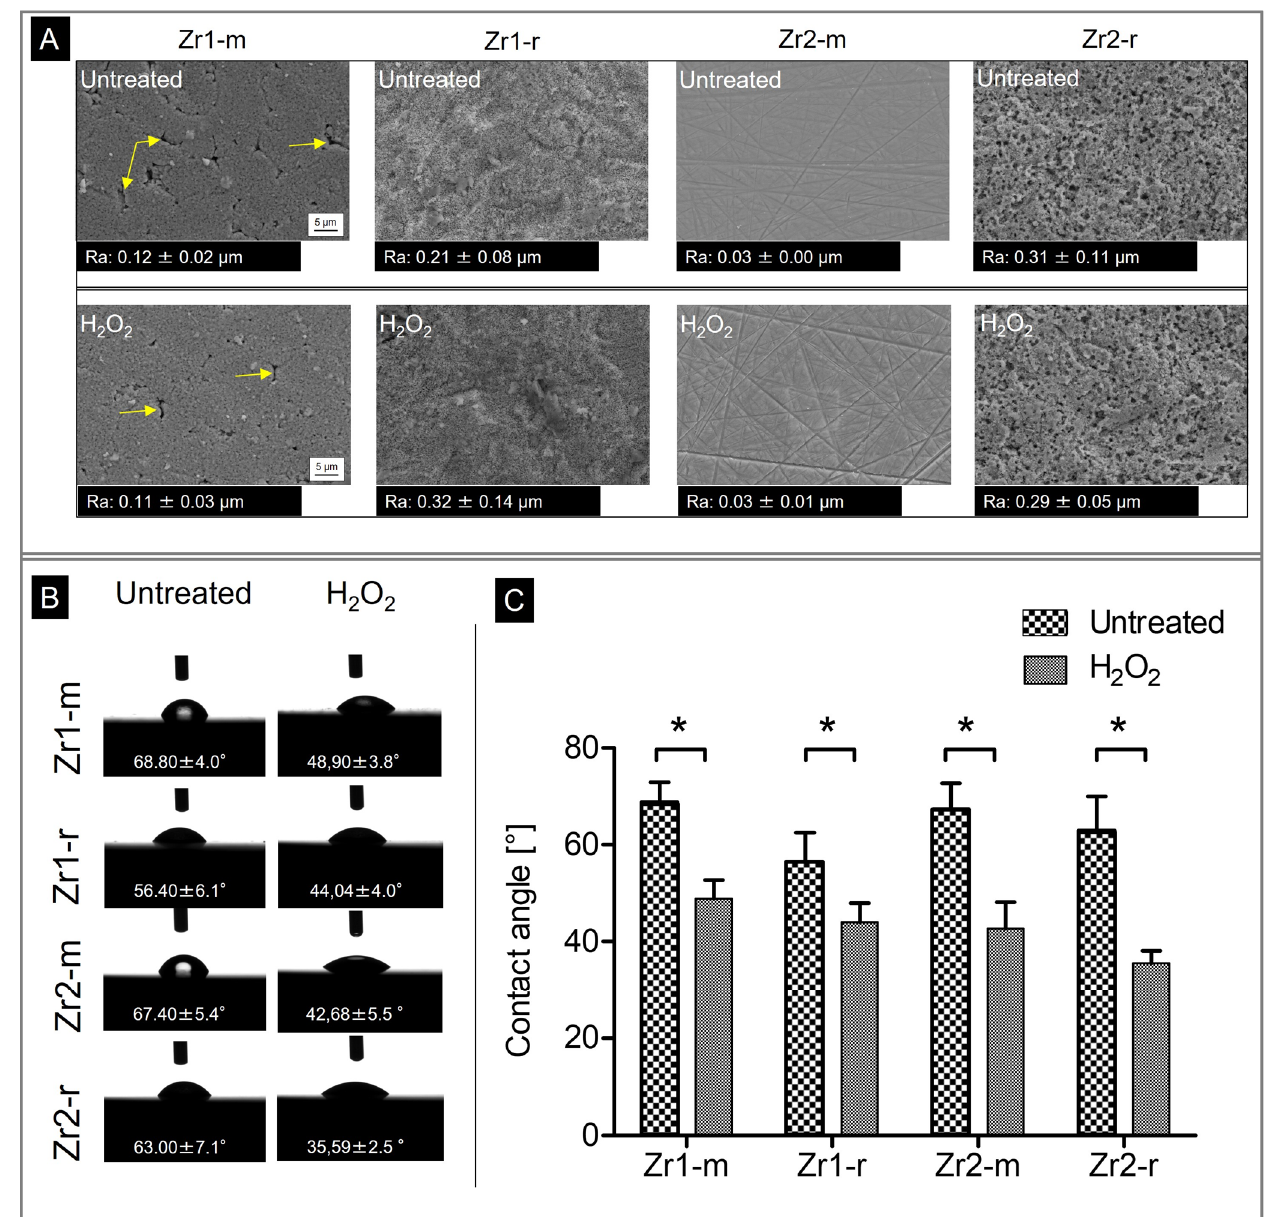
Figure 1. ( A – C ) Morphology of the zirconia-based surfaces before and after H 2 O 2 -treatment and changes in their hydrophilic properties after H 2 O 2 -treatment. ( A ) SEM images at 5000 × magnification of the four untreated and H 2 O 2 -treated surfaces Zr1-m/r and Zr2-m/r (mean average roughness data ± SD (Ra in µm) given below SEM images). ( B ) Representative photographic images of contact angle measurements of 1 µL water droplets pipetted onto zirconia discs with and without H 2 O 2 - treatment for 2 h (mean contact angles ± are embedded in the contact angle images). ( C ) Comparison of the contact angle development with and without H 2 O 2 -treatment between the four different samples. Statistical significances with p < 0.05 are labeled with “*” in the graphs.